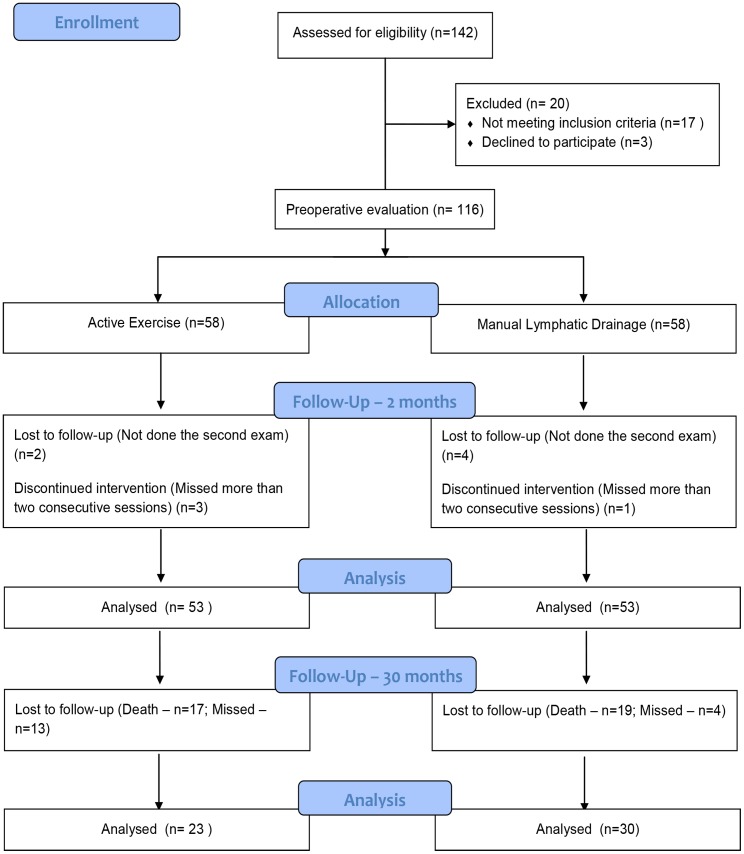
Flowchart of study sample.